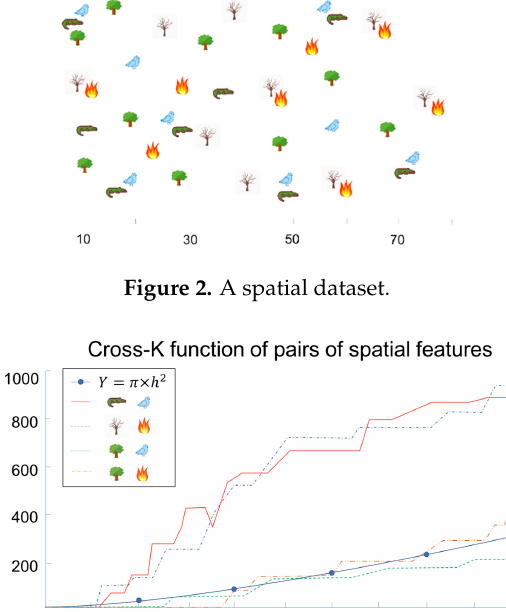
Figure 3. Cross-K function of four feature pairs.